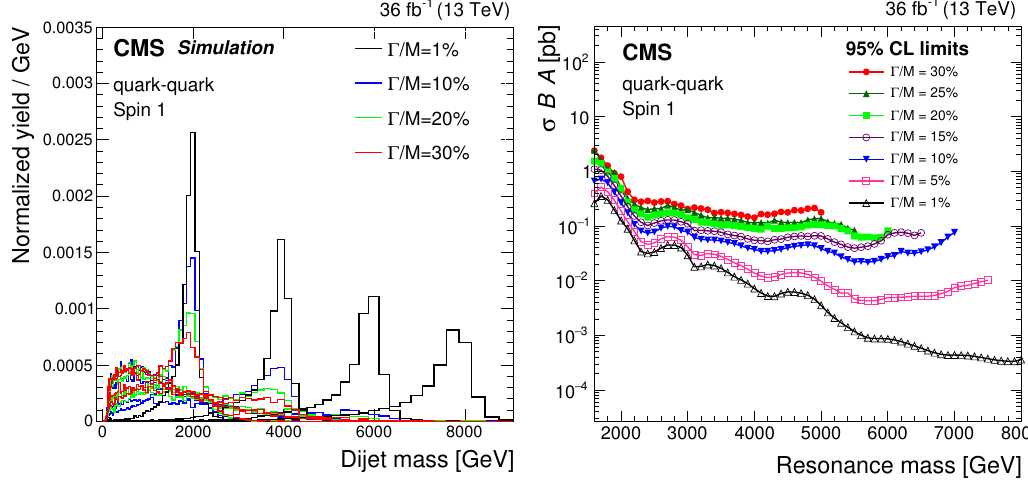
Figure 18 . The resonance signal shapes (left) and observed 95% CL upper limits on the product of the cross section, branching fraction, and acceptance (right) for spin-1 resonances produced and decaying in the quark-quark channel are shown for various values of intrinsic width and resonance mass. The reconstructed dijet mass spectrum for these resonances is estimated from the pythia 8 MC event generator, followed by the simulation of the CMS detector